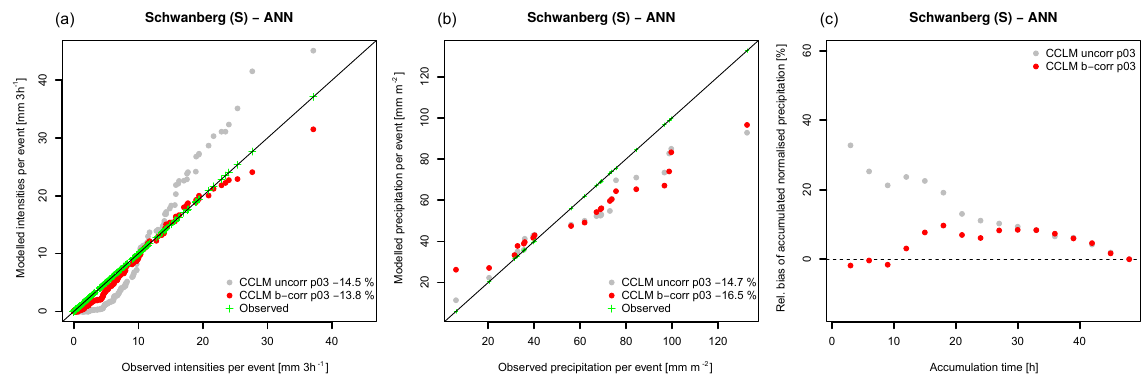
Figure 10. Comparison between modelled (CCLM 3km), bias-corrected and observed precipitation characteristics tied to the 22 MAF events in the Schwanberg catchment. (a) shows the single precipitation intensities. (b) depicts the total precipitation per event (defined as the 2-day period before the maximum peak flow). (c) shows the (event averaged) relative bias of the accumulated precipitation amount (normalised by the events’ total precipitation) prior to the flood events as a function of its accumulation time. Numbers in the legends give the relative median bias of the plotted